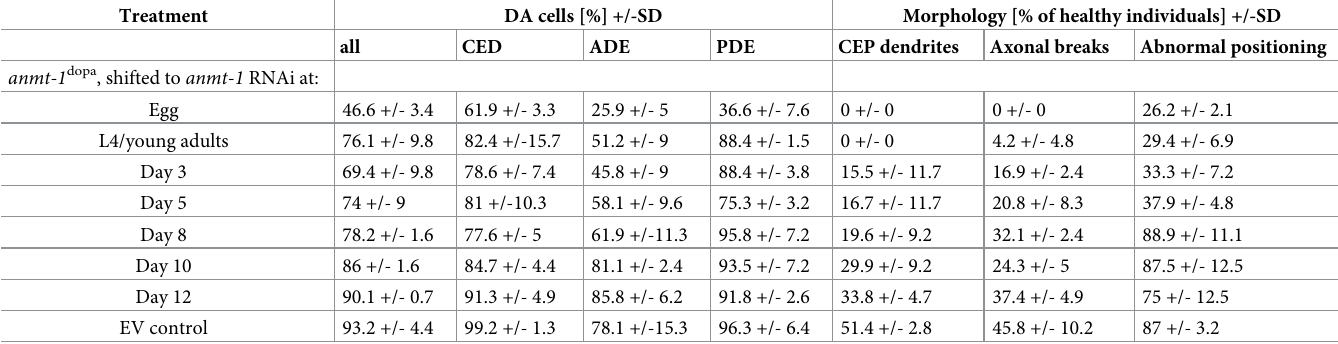
Table 1. Effects of anmt-1 RNAi on neurodegeneration at day 15 of adulthood in anmt-1 dopa with a neuronal RNAi-sensitive background.